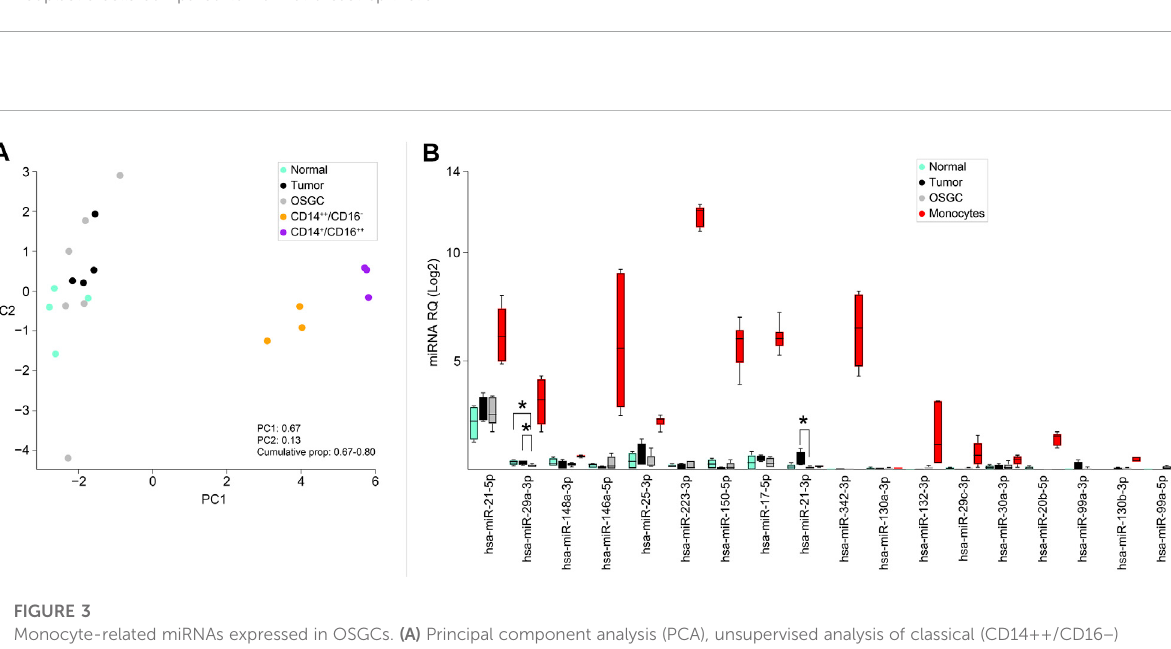
FIGURE 2 miRNA signatures in the different cellular compartments of breast cancers with OSGC. (A) Unsupervised separate analysis of microdissected samplesofnormalbreastepithelium,cancercells,andOSGC,showingthatOSGChavemiRNApro fi lesmoresimilartocancersamplesratherthanto normal cells. (B) Differentially expressed miRNAs between cancer cells and normal epithelial cells in breast cancers with OSGC. (C) OSGC grouping togetherwithneoplasticcellstissuesbasedonmiR-181a-5p/miR-181b-5pupregulationandmiR-143a-3p/miR-195a-5pdownregulationinthe neoplastic cells compared to normal breast epithelium.